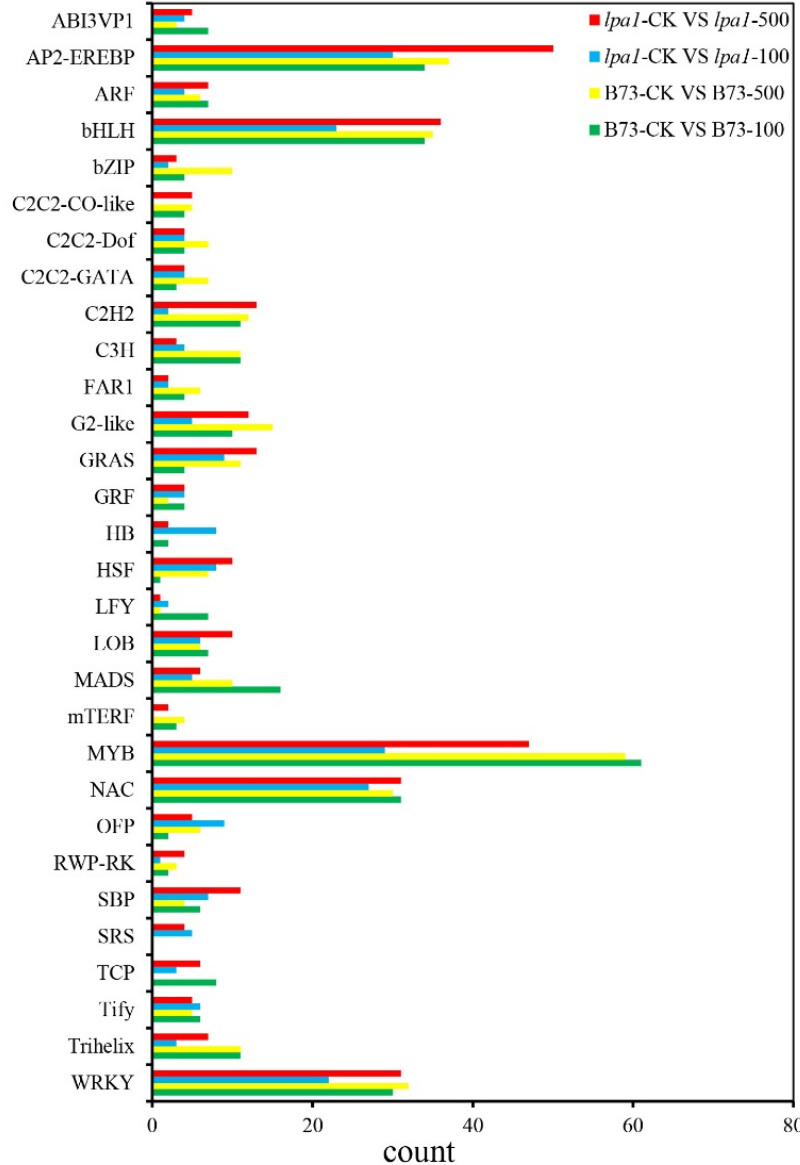
Figure 8. Analysis of transcription factors differentially expressed in B73 and lpa1 under different treatments.